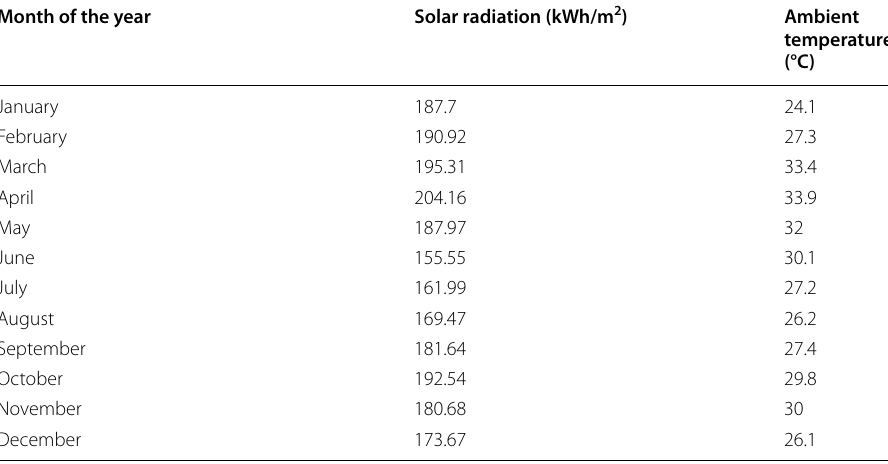
Table 1 Solar radiation and ambient temperature of Waza [37] Month of the year Solar radiation (kWh/m 2 ) Ambient